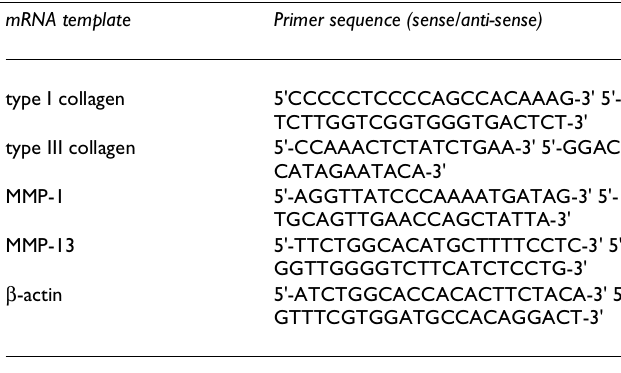
Table 1: Primer sets used for RT-PCR mRNA template Primer sequence